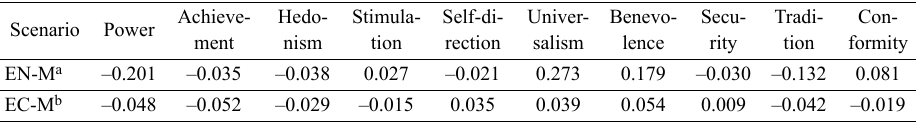
Table 4. The indirect effect of types of personal values on EER Achieve- Hedo- Stimula- Scenario Power ment nism